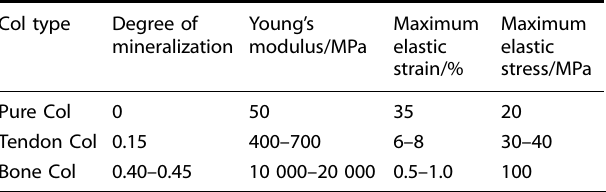
Table 2. Effects of mineralization degree on the